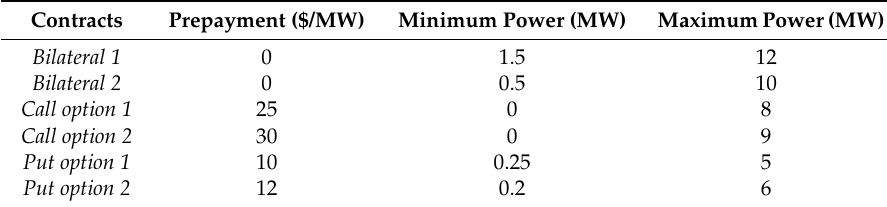
Table 6. Contracts’ general data.